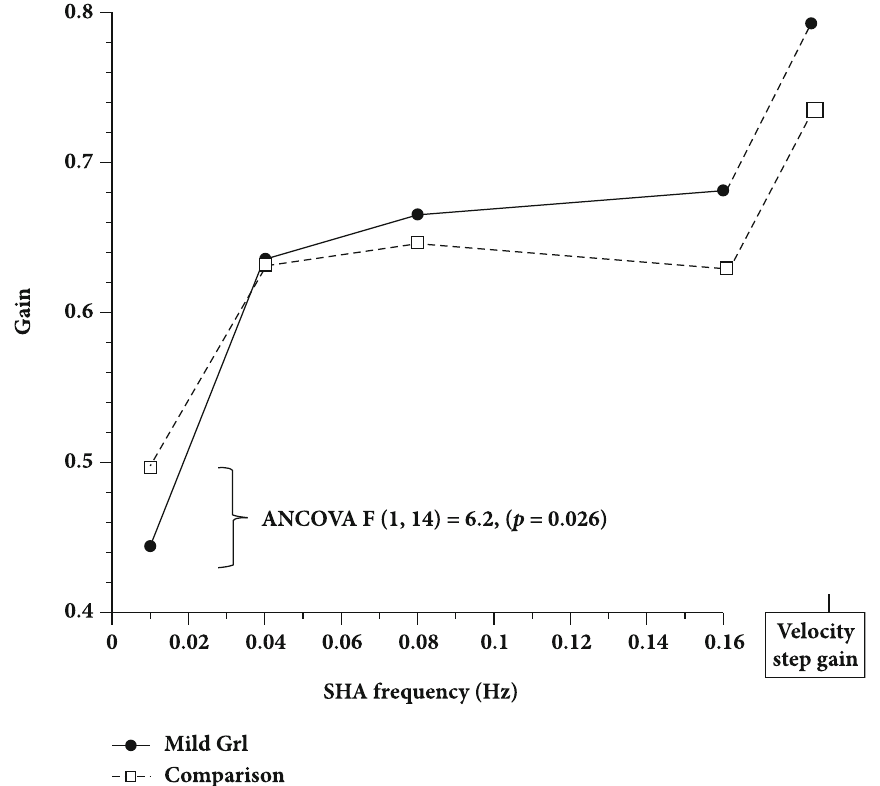
Figure 2: MGrI and comparison group SHA and velocity step